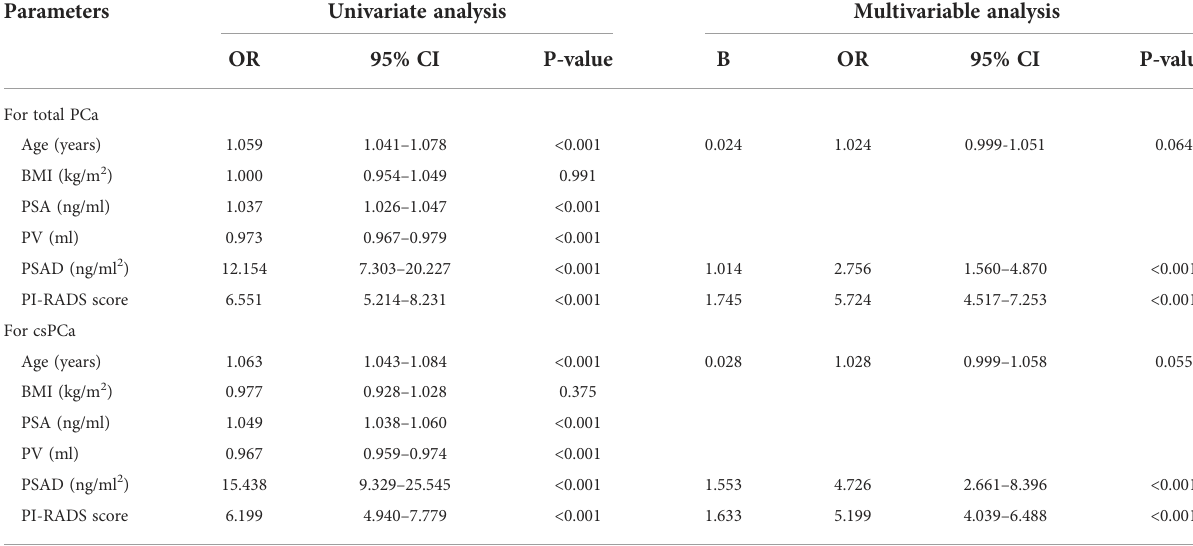
TABLE 1 Univariate and multivariable analysis for screening out the independent factors of total PCa and csPCa. Parameters Univariate analysis Multivariable analysis OR 95% CI P-value B OR 95% CI